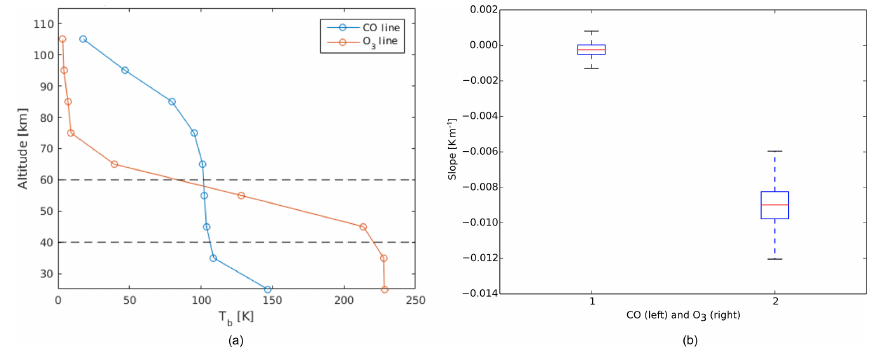
Figure 3. (a) Peak brightness temperatures of CO and O 3 at different altitudes. Average considering all observations performed during the PLL working period, i.e. 14224 scans. At altitudes between 40 and 60km, the CO line curve presents a steeper slope. (b) Linear fit of slopes of peak brightness temperatures between 40 and 60km altitude for CO and O 3 . The shown uncertainties on slopes correspond to 3 σ .